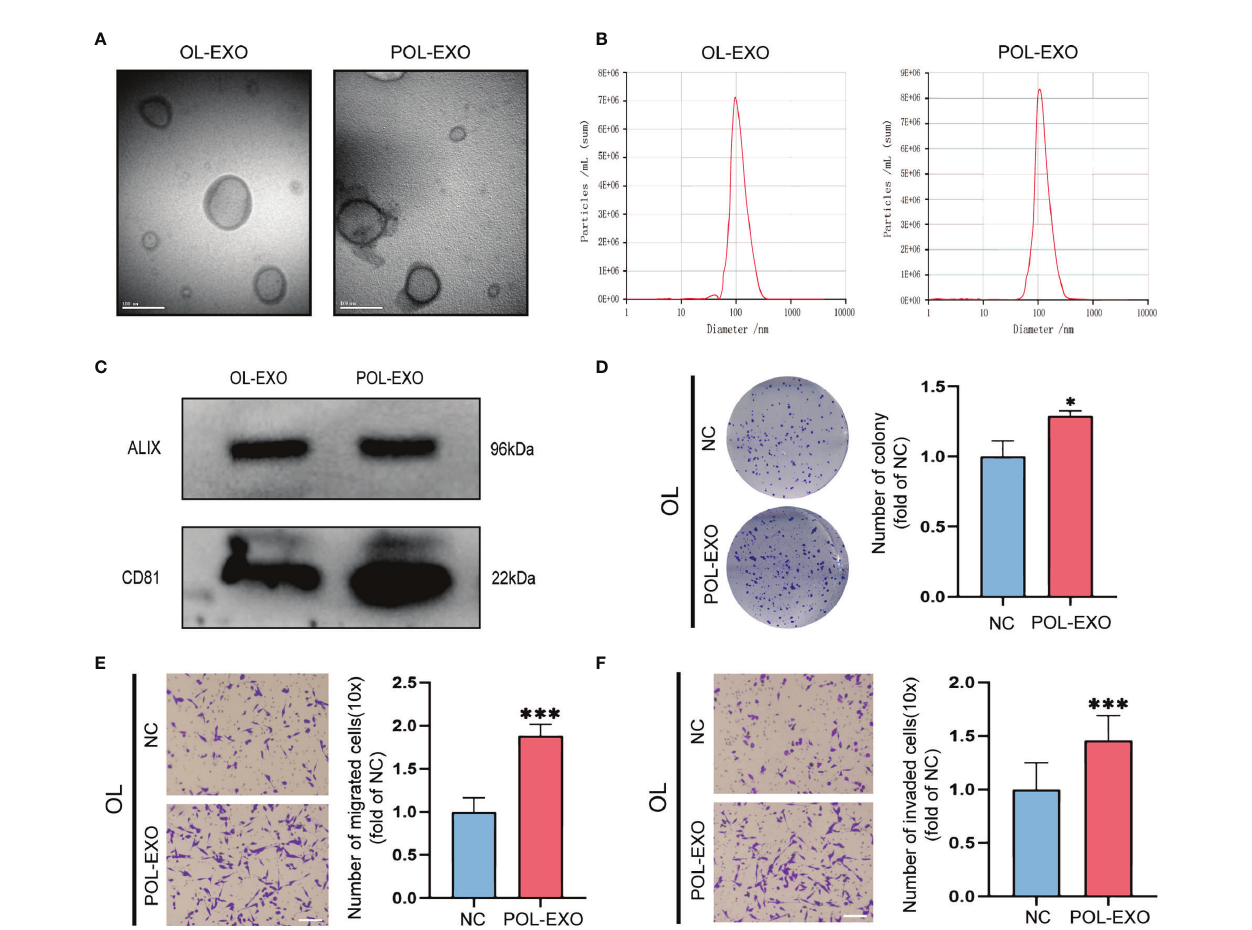
FIGURE 1 | Exosomes derived from POL cells promoted the metastasis of OL cells. (A) Representative electron microscopy micrographs of exosomes isolated from OL and POL cells, bar = 100nm. (B) NTA analysis to determine the size distribution and number of exosomes. (C) WB analysis of exosome markers ALIX and CD81 expression. The effect of exosomes secreted by POL cells (POL-EXO, 40 m g) on the proliferation of OL cells was measured using colony formation assays (D) , *p < 0.05). Transwell assays without Matrigel or with Matrigel were used to determine the effect of POL-EXO on the migration (E) , bar = 60 m m, ***p < 0.001) and invasion (F) , bar = 60 m m, ***p < 0.001) of OL cells,